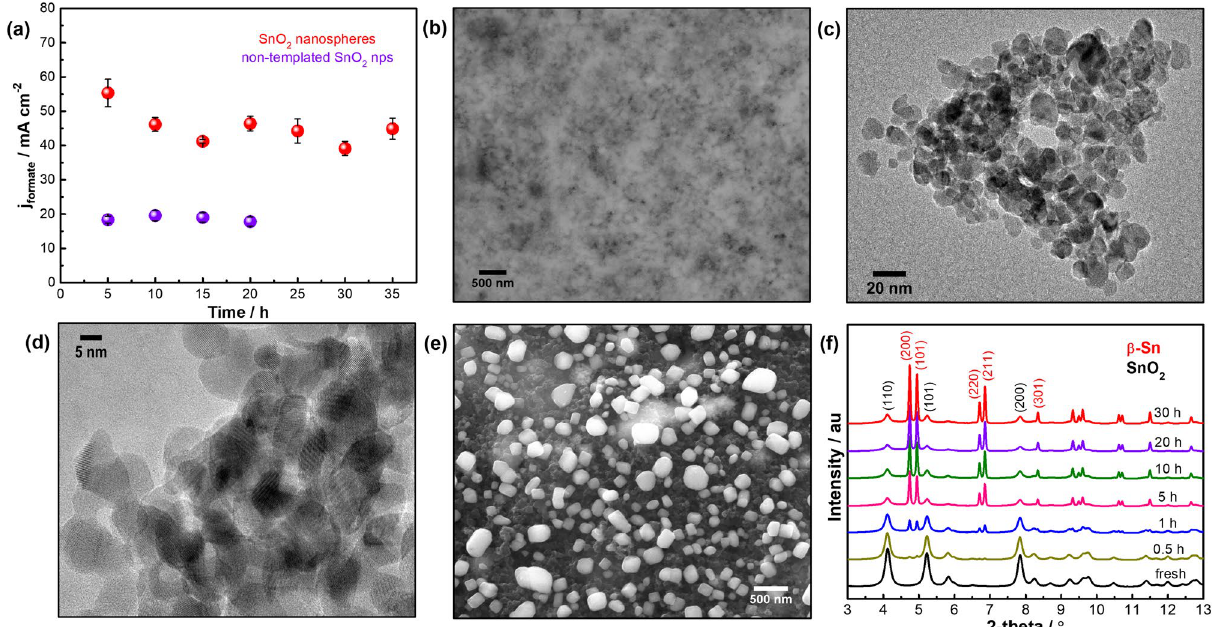
Figure 3. ( a ) Long-term CO 2 RR performance of the best performing SnO 2 nanospheres and non-templated SnO 2 nps at −1.2 V vs. RHE. The experiments were run intermittently over multiple 5-h electrolysis periods. ( b ) Back-scattered SEM and ( c , d ) TEM images of SnO 2 nanospheres electrode after 35 h of operation. ( e ) SEM image of non-templated SnO 2 nps after 20-h electrolysis. ( f ) Time-dependent synchrotron-based XRD profiles of SnO 2 nanospheres collected at −1.2 V vs.